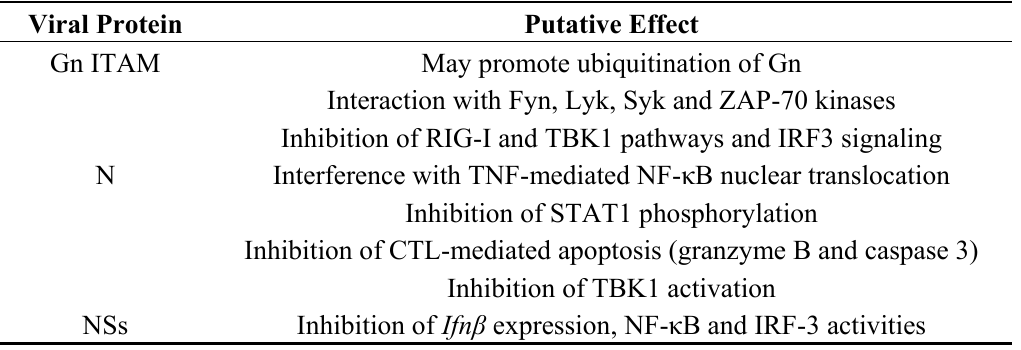
Table 2. Hantavirus proteins that may have immunomodulatory